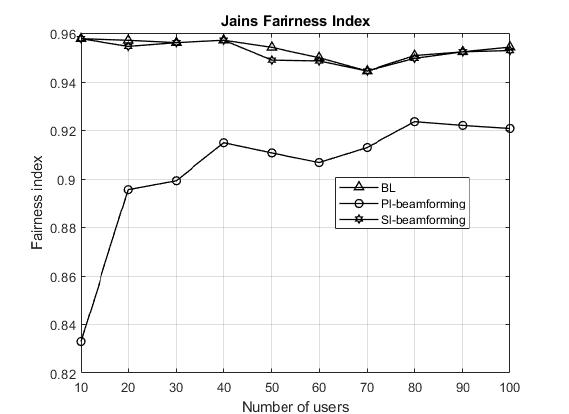
Figure 3. Network fairness in comparison to the baseline